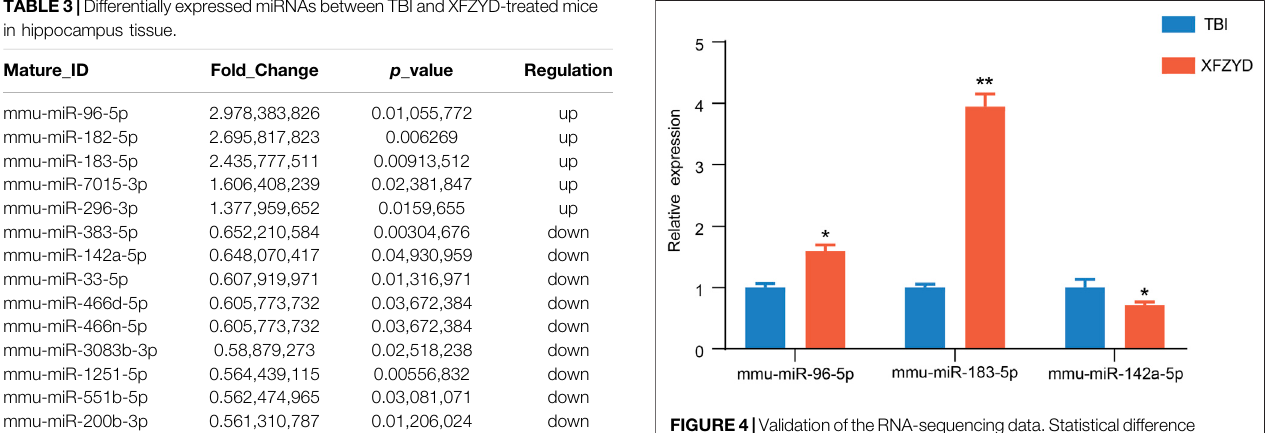
FIGURE4| ValidationoftheRNA-sequencingdata.Statisticaldifference analysis of the relative expression levels of miR-96-5p, miR-183-5p, and miR- down 142a-5p in TBI and XFZYD groups. Data are exhibited as mean ± SEM, n = 5 mice per group, * p < 0.05, ** p <